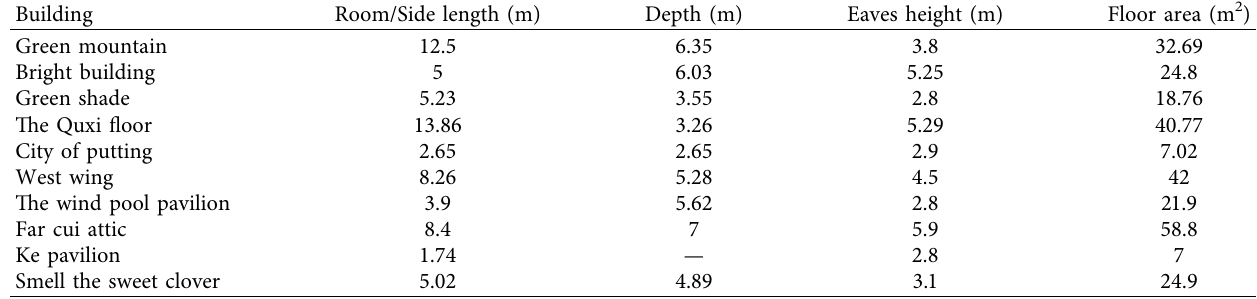
Table 2: Quantification of building scale in the middle of Liu Yuan.